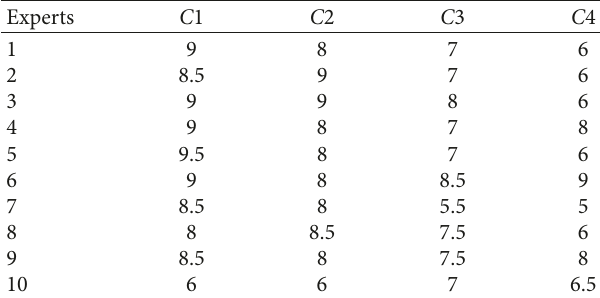
Table 9: The evaluation index matrix of the first-level